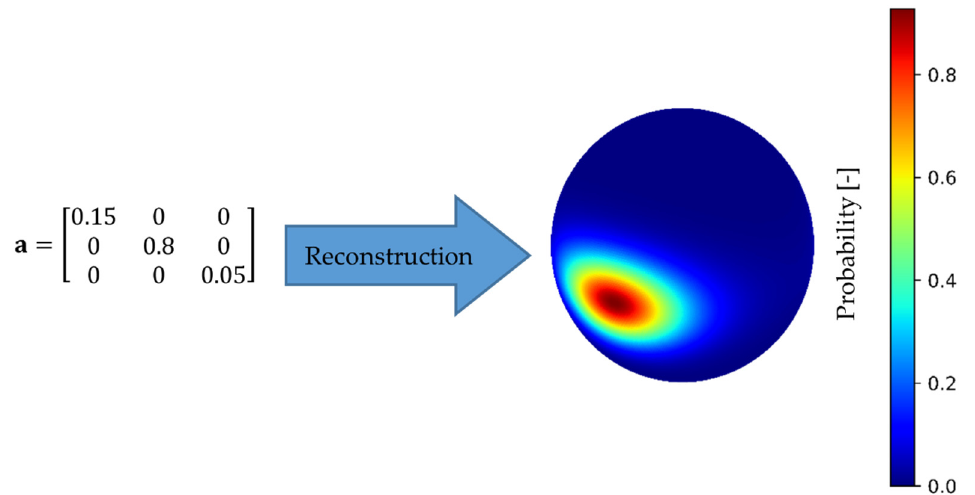
Figure 6. Reconstructed ODF by the maximum entropy method of the shown fiber orientation tensor of second order. The color shows the probability that a fiber points in this direction. of second order. The color shows the probability that a fiber points in this